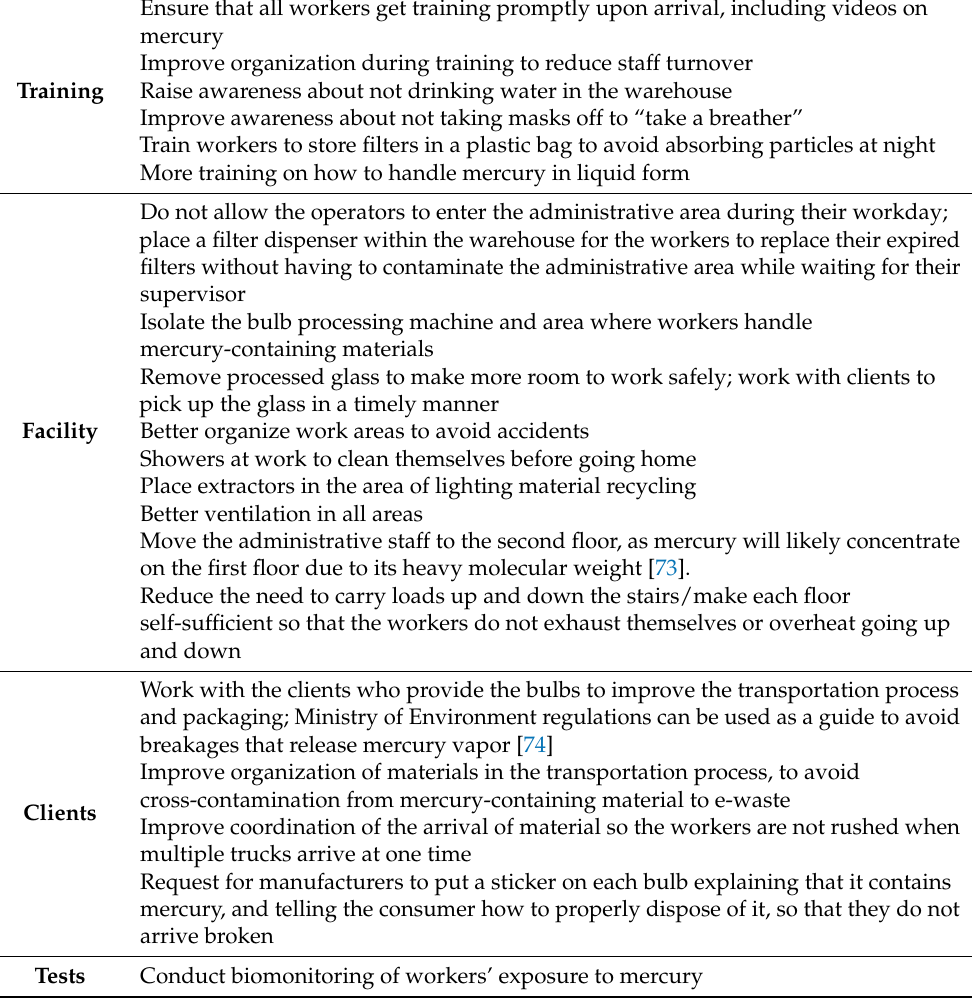
Table 1. Workplace safety improvements recommended by recycling workers to reduce hazardous exposures to